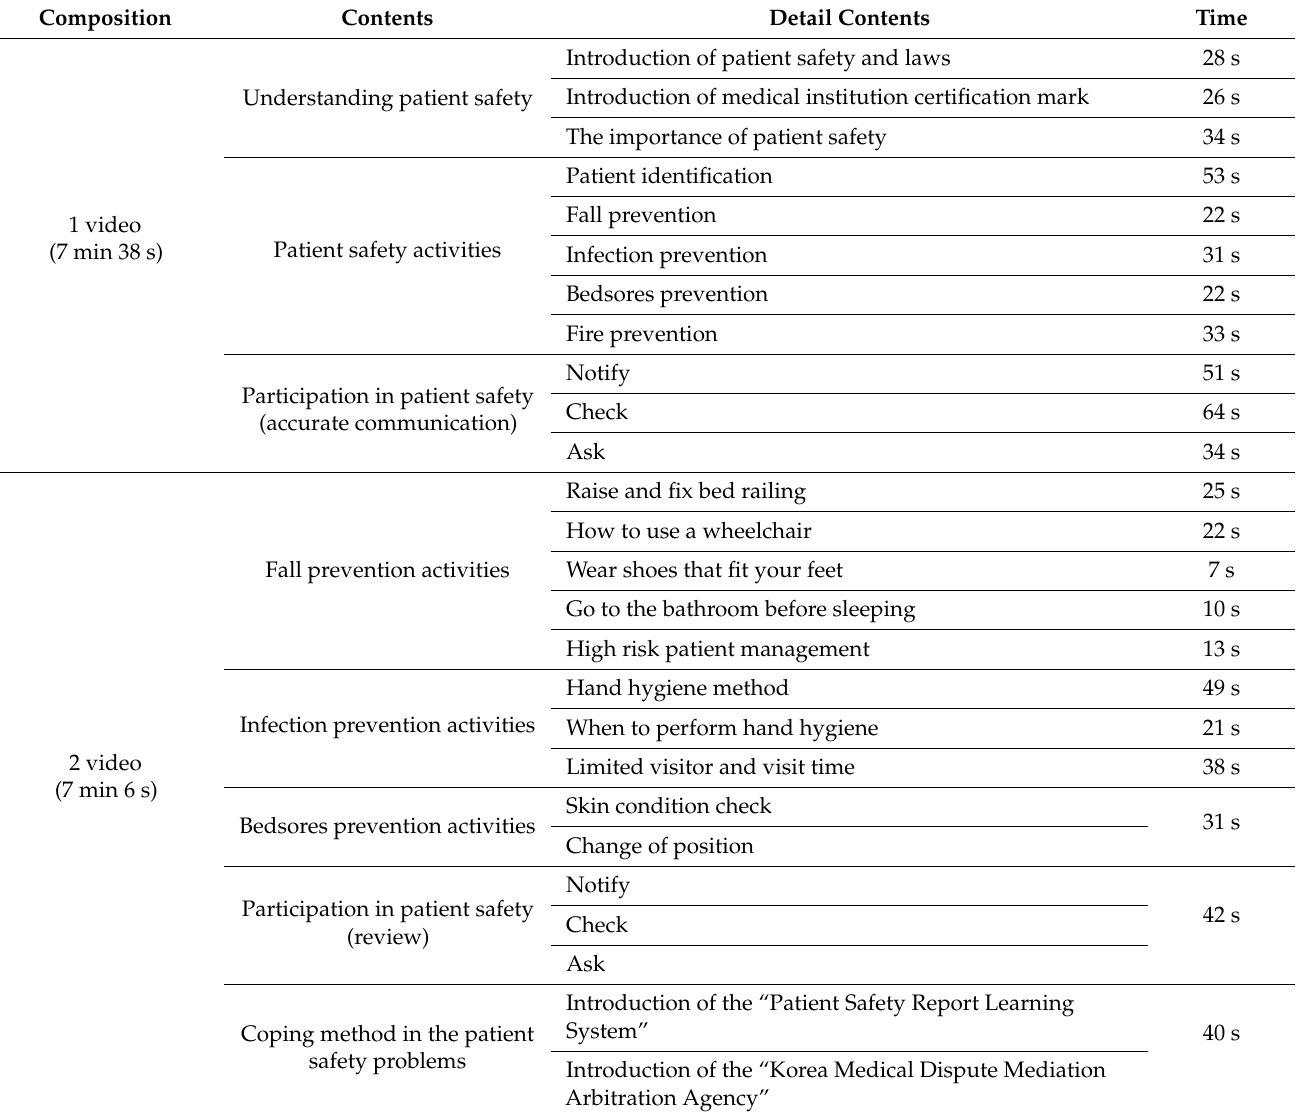
Table 1. Patient Safety Prevention